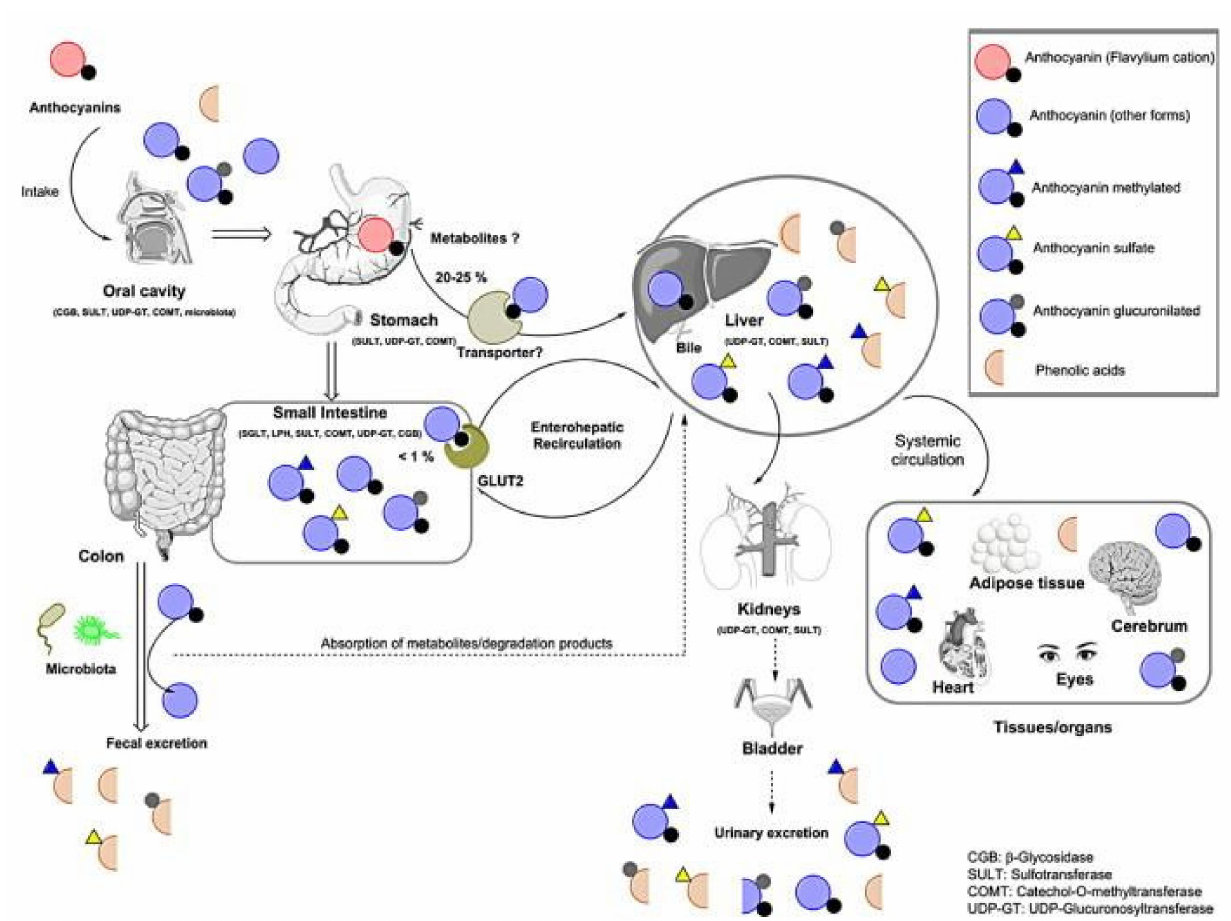
Figure 5. Proposed scheme for the metabolism, distribution, absorption, and excretion of ANs. Copyrights Fernandes et al.